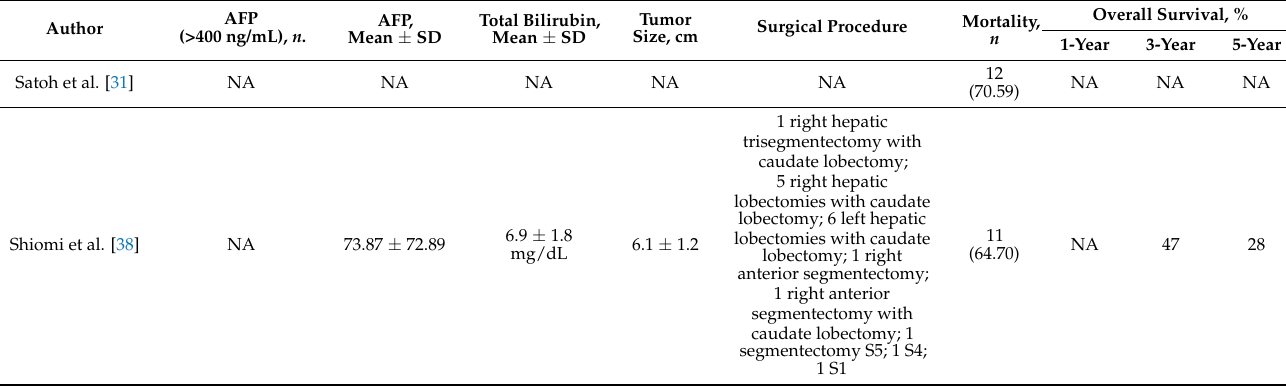
Table 2. Literature review: pre-, intra-, and postoperative